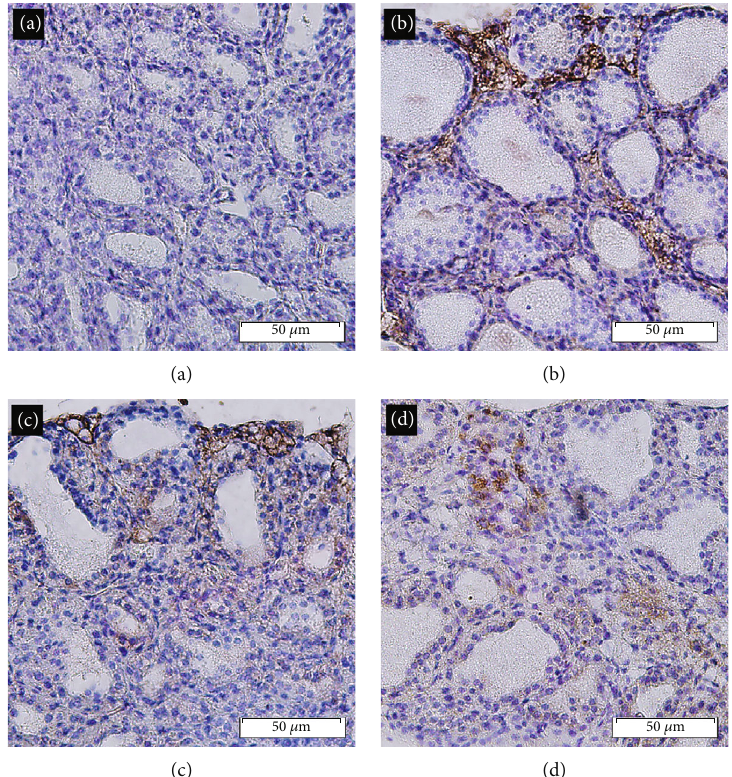
Figure 2: IHC ( × 200). (a) Negative control thyroid section. (b) CD4 positivity was found in the in fl ammatory cells around thyroid follicles. (c) ROR γ positivity was found in the in fi ltrated lymphocytes. (d) IL-17A expression was detected in the in fi ltrated lymphocytes, especially in the areas near the damaged thyroid follicles.